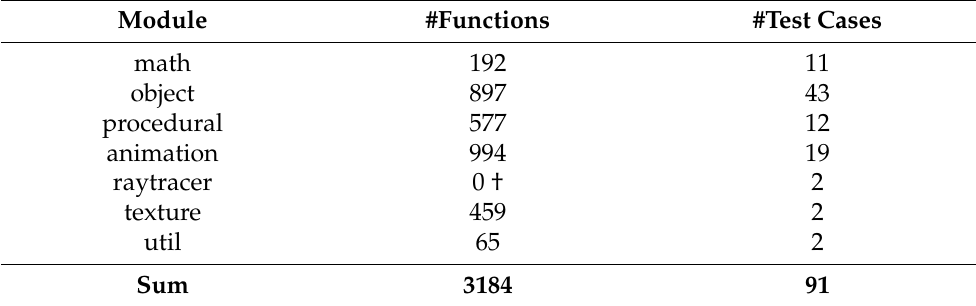
Table 2. Dataset information with functions and test cases in Project ArtOfIllusion . # Functions indicates the number of functional units in the module. # Test Cases indicates the number of test cases that are manually-written for testing the